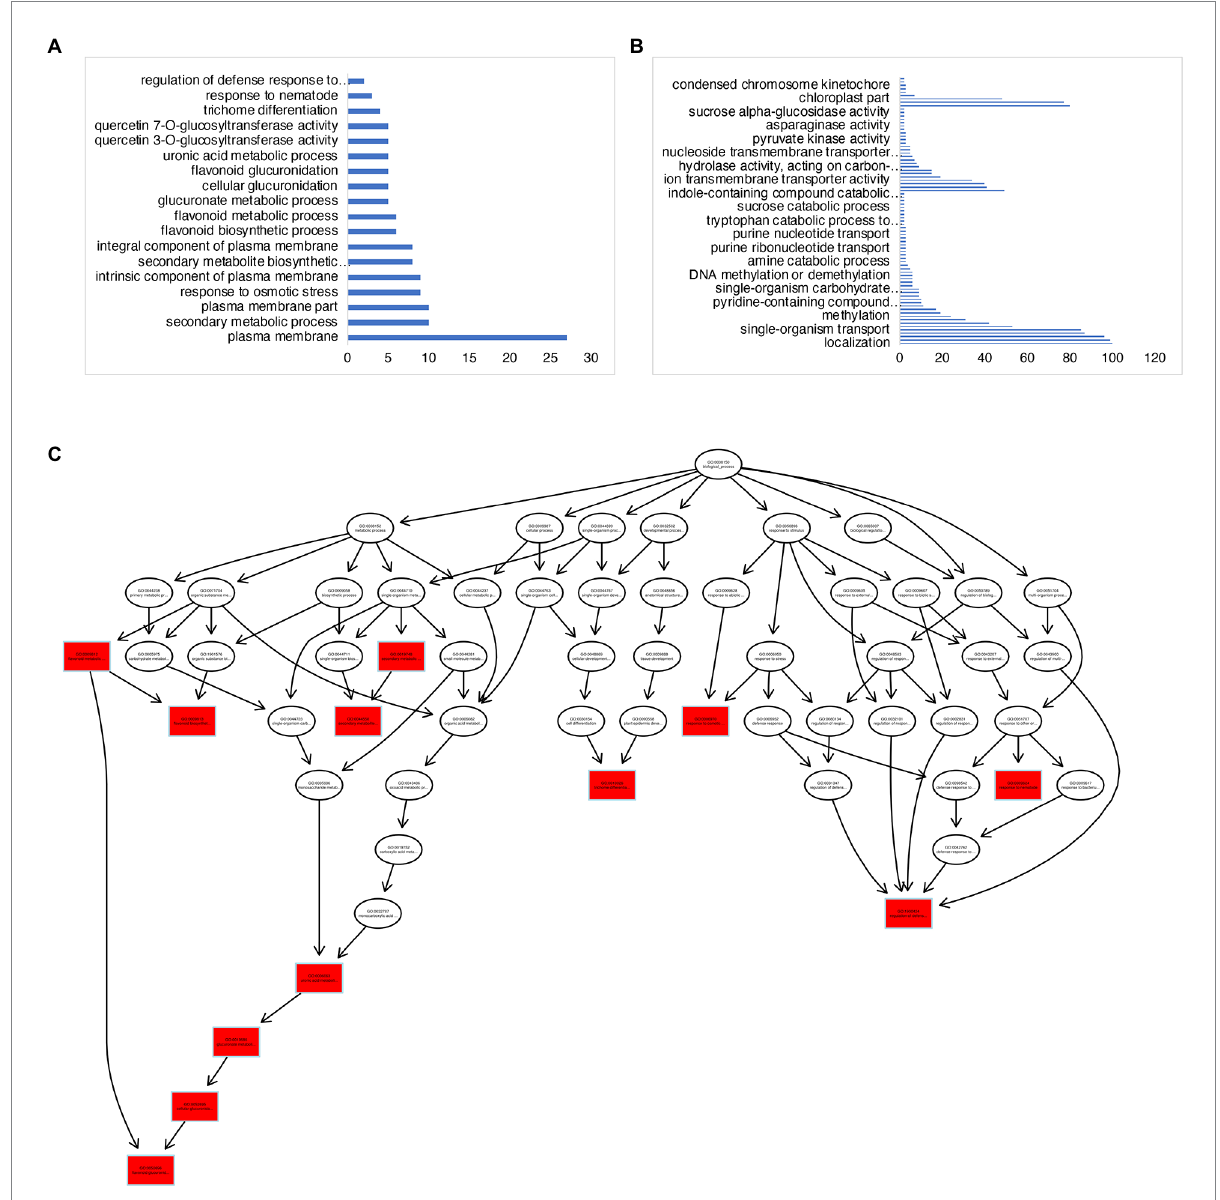
FIGURE 4 GO-term analysis on the E-L 35- and E-L 38-specific genes in “Noble.” (A,C) GO terms analysis of the E-L 35-specific genes showing enrichment for a GO term were in flavonoid biosynthetic and metabolic process, quercetin and glucuronate biosynthesis, and metabolic process. (B) Genes expressed at maturity (E-L 38) that were involved in methylation and epigenetic